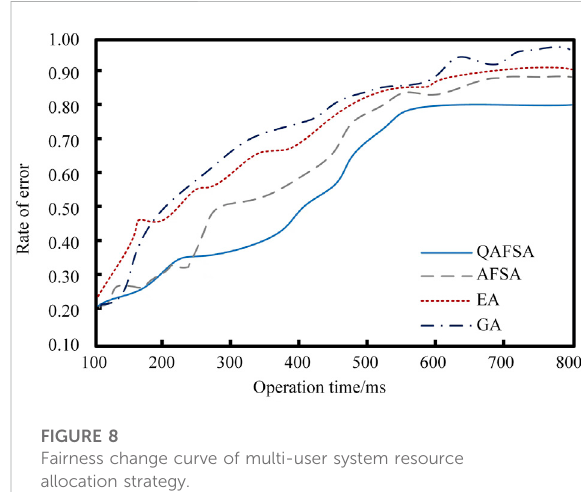
FIGURE 8 Fairness change curve of multi-user system resource allocation